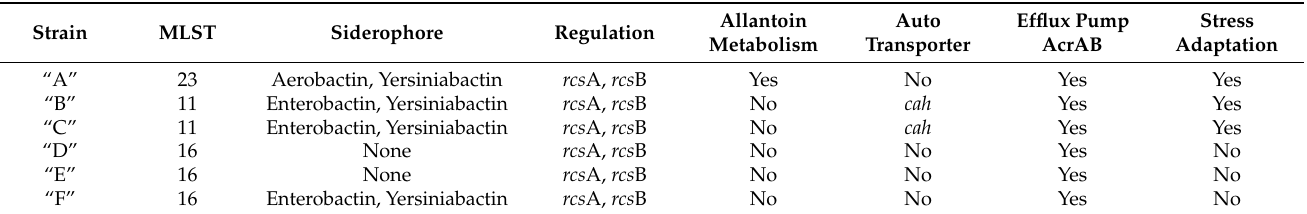
Table 1. Virulence factors and ST of all six strains used for the zebrafish model, according to